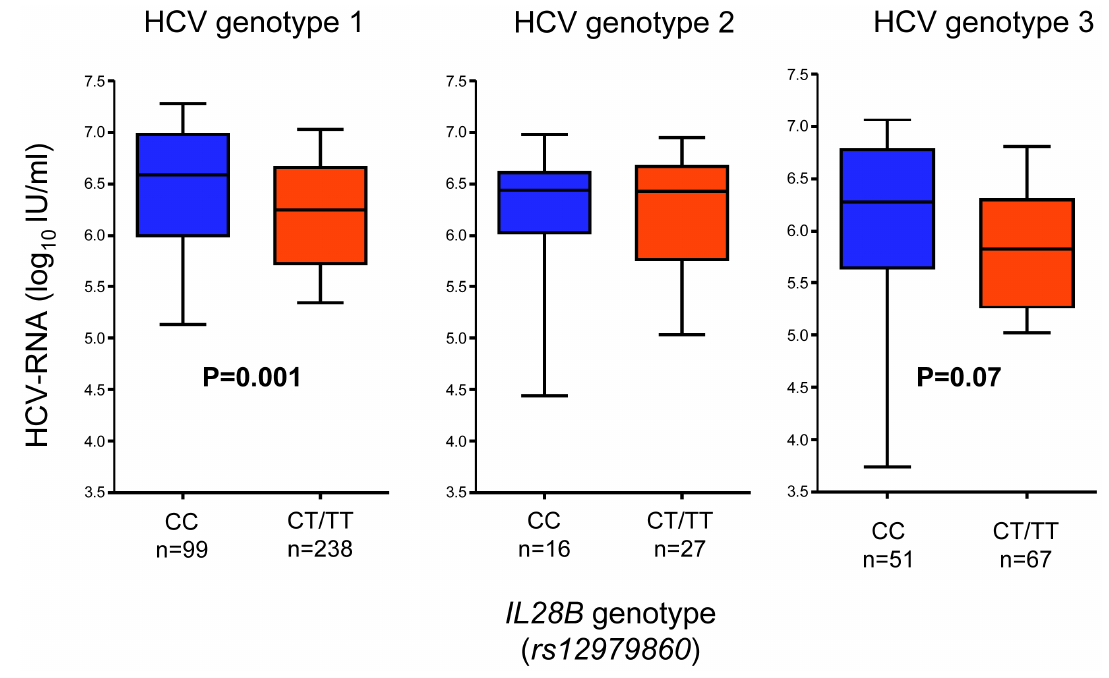
Figure 5. Tenth, 25 th , 50 th , 75 th , and 90 th percentiles of HCV RNA level in relation to IL28B . doi:10.1371/journal.pone.0080172.g005 PLOS ONE |